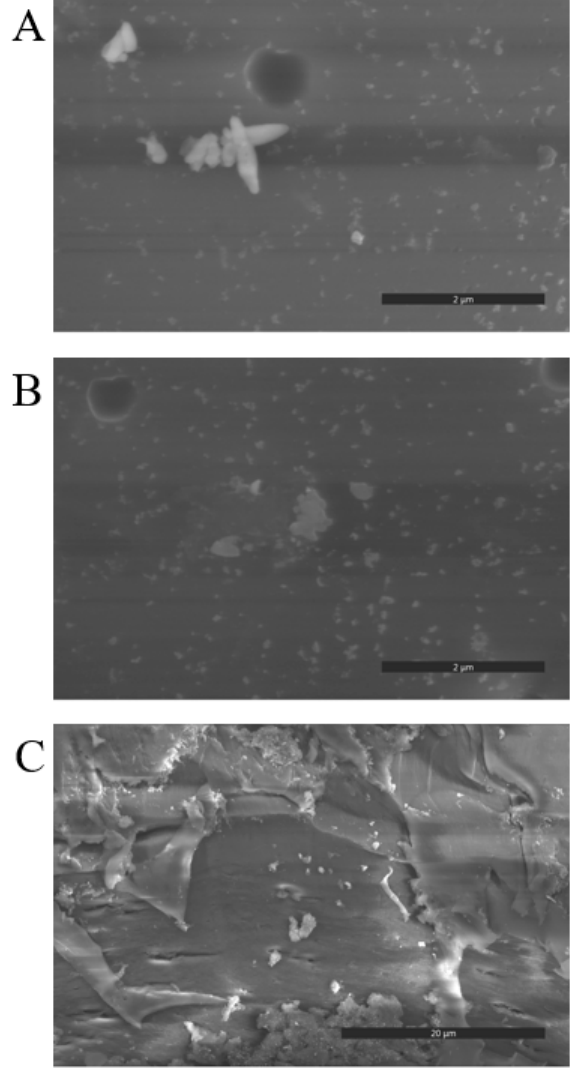
Figure 3. SEM images of both surfaces ( A ) (top) and ( B ) (bottom) of the SPES@HKUST-1 membrane (5 wt. % of HKUST-1), and its cross-section ( C ).